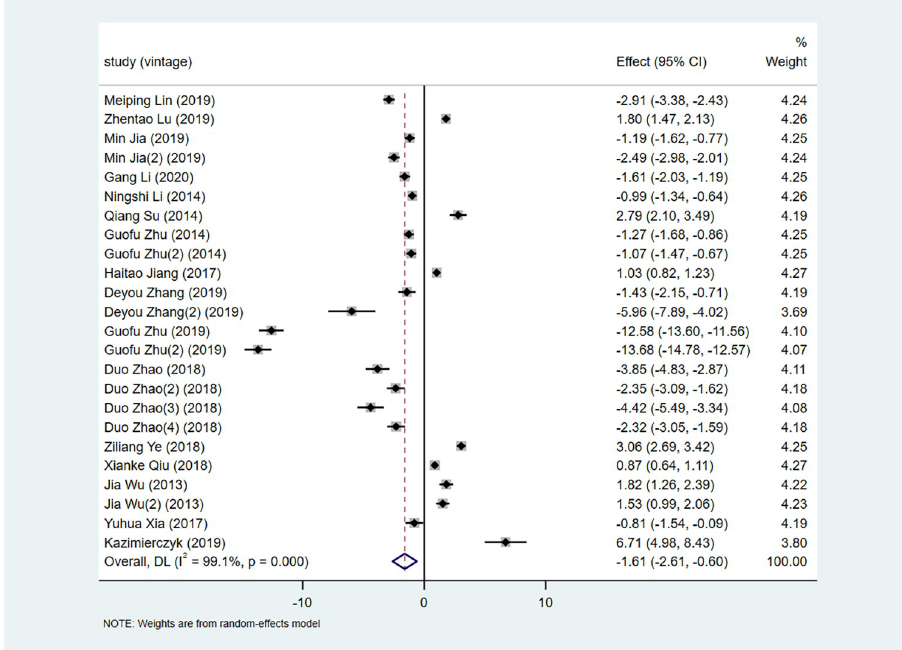
Fig 2. Forest plot of microRNA-155 association with